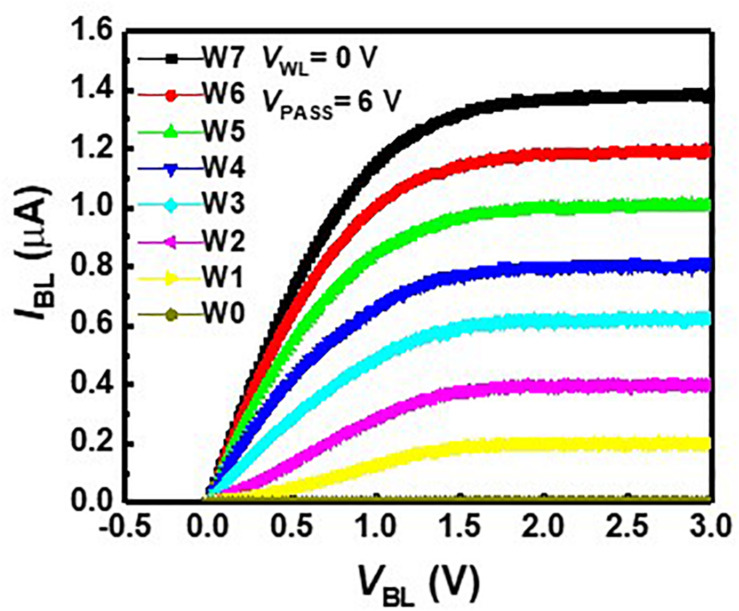
IBL–VBL characteristics with various weight levels at a VPASS of 6 V and a VWL of 0 V.